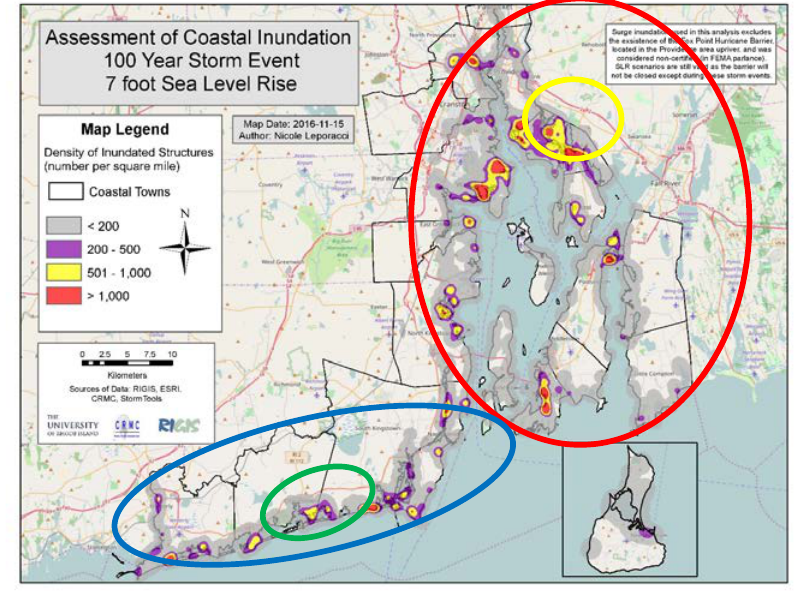
Figure 2. Density of structures inundated with 100-yr storm surge plus 7 ft (2.1 m) sea level rise (SLR) for Narragansett Bay, RI, and the southern coast of RI based on STORMTOOLS. The red and blue ovals show the Narragansett Bay and southern RI shoreline study areas, respectively. The green oval shows the location of Charlestown, RI, and the yellow oval the towns of Barrington, Warren and Bristol, RI. study areas ( http://www.beachsamp.org/wpcontent/uploads/2016/11/Map_SLR7_100YR_Edited_11_15.jpg, accessed, 26 October